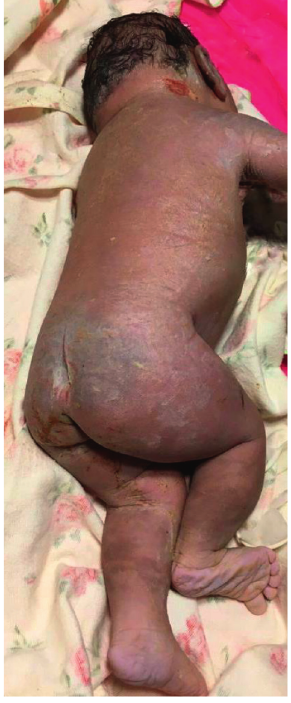
Figure 4: No spina bifida or club foot.